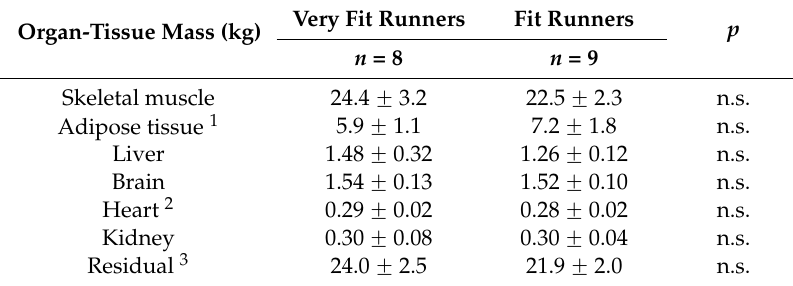
Table 2. Body composition at the organ-tissue level.